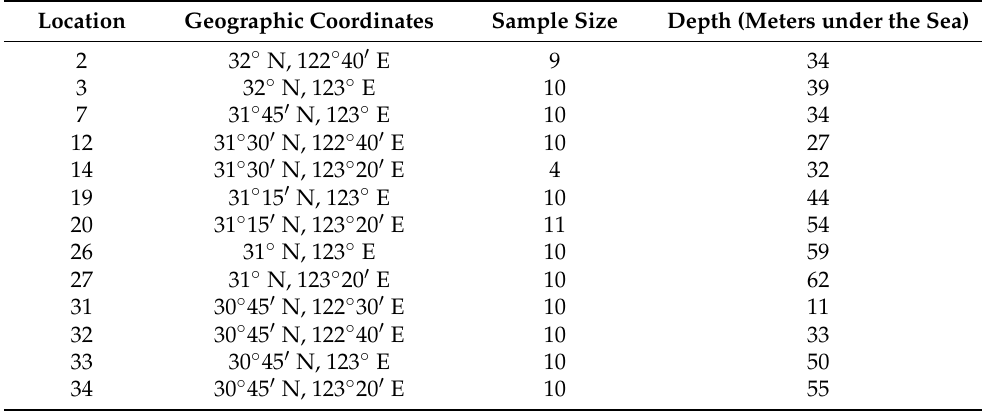
Table 1. Summary information on the 13 sampled